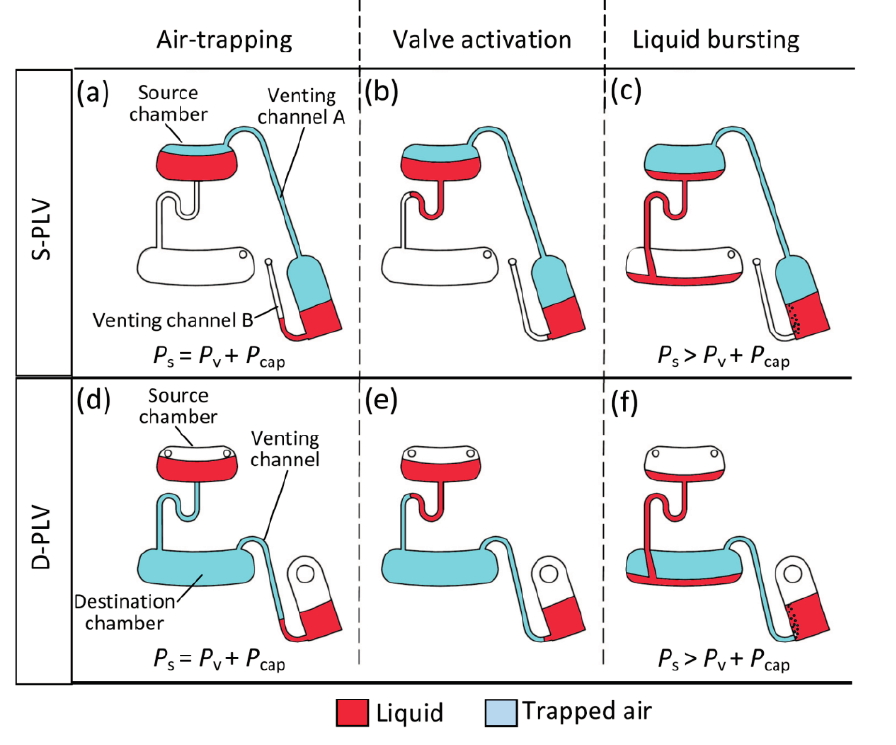
Figure 2. Liquid valving sequence, ( a ) S-PLV at low frequency; ( b ) high spinning speed where the source chamber liquid starts to flow inside the micro-channel, creating a lower pressure effect in the venting chamber; ( c ) high frequency, the source chamber liquid bursts into the destination chamber; ( d ) D-PLV at low frequency; ( e ) high speed, the source chamber liquid starts flowing into the microchannel, creating compression state in the destination chamber; ( f ) high frequency, the source chamber liquid bursts into the destination